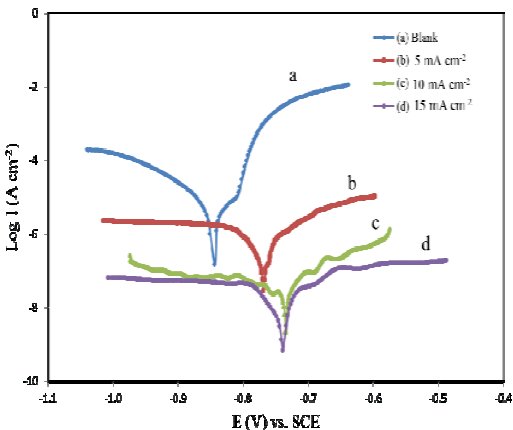
Fig 8. Polarization behavior of electropolymerzied polyaniline-TiO nanocomposite- coated on AA3004 2 at various current densities (mAcm -2 ) in 3.5%